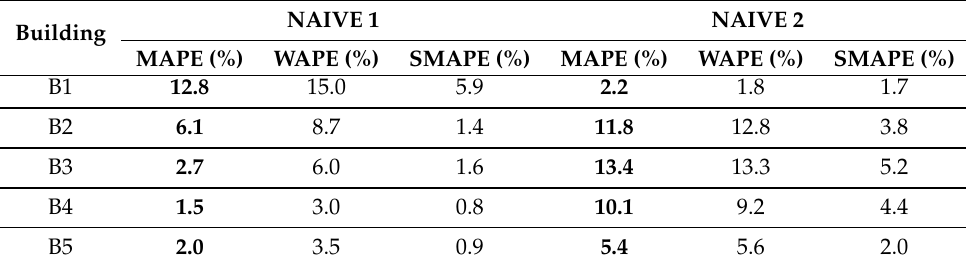
Table 11. Improvement in terms of prediction error reduction of the artificial neural network